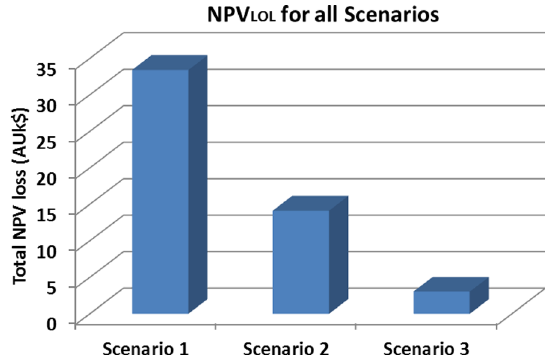
Fig. 3. NPV LOL , total NPV loss due to LOL, for different scenarios over planning period.